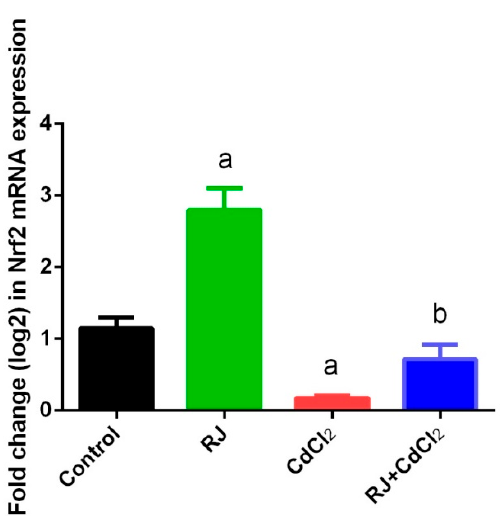
Figure 6. Effects of royal jelly (RJ) on the mRNA level of nuclear factor (erythroid-derived 2)-like-2 factor (Nrf2) in testes of mice exposed to cadmium chloride (CdCl 2 ). All values are expressed as mean ± SEM of triplicate assays and were normalized to the GAPDH mRNA levels and are shown as the fold induction (in log2 scale) relative to the mRNA levels in the controls. a refers to a significant change from the control mice at p < 0.05; b refers to a significant change from the CdCl 2 -treated mice at p < 0.05, using Duncan’s post hoc test.